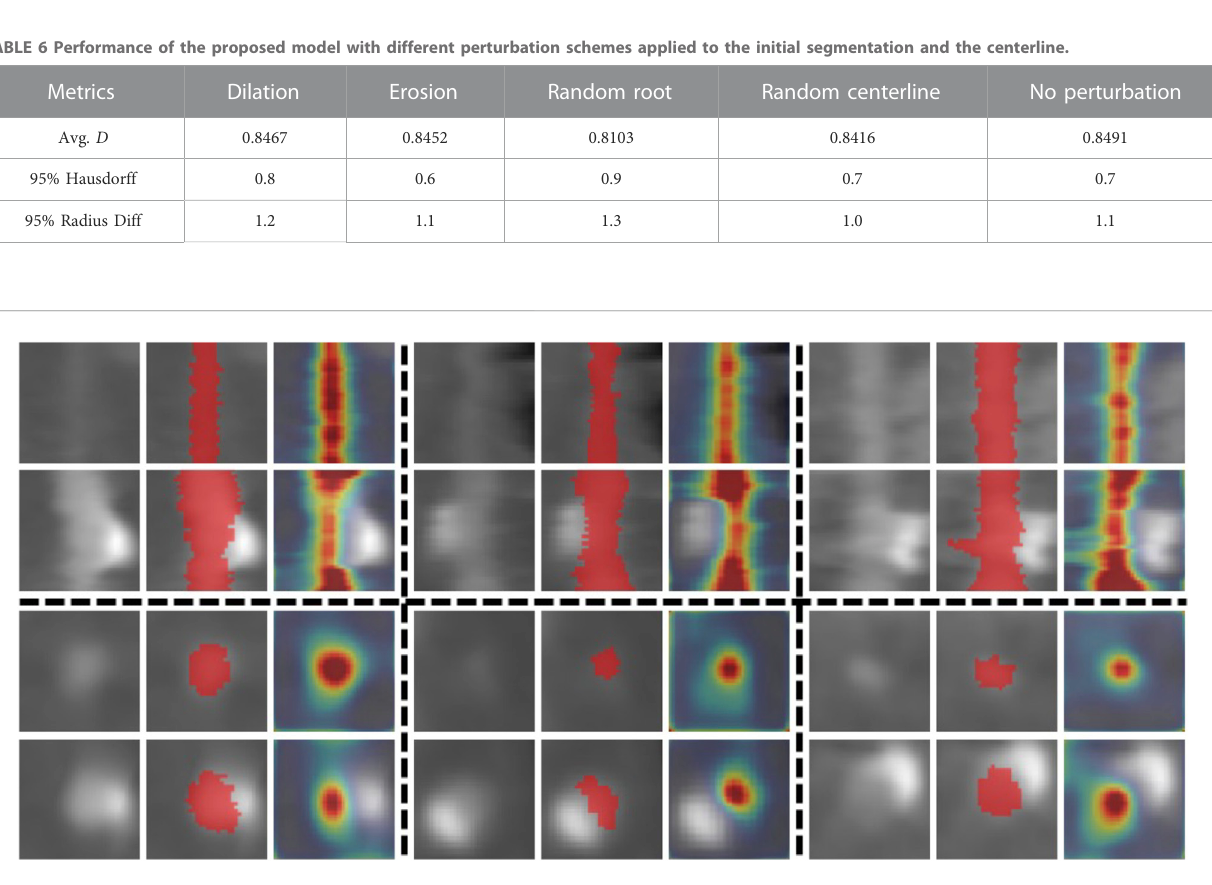
FIGURE 6 Attention examples. The 1 st , 4 th , and 7 th columns show input subvolumes. The 2 nd , 5 th , and 8 th columns show the corresponding ground truths (red) overlaidontheoriginalsubvolumes.The3 rd ,6 th ,and9 th columnsshowthegeneratedattentionmapsoverlaidonthesubvolumes.Thetoptworowsshow some examples viewed along the coronary artery. The bottom two rows show samples viewed in the cross-section